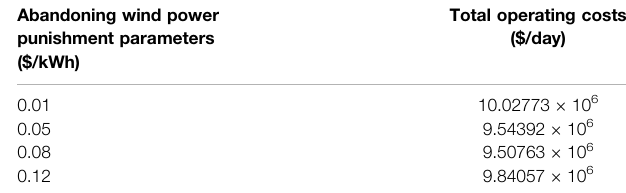
TABLE 5 | Comparison of total operating costs with different abandoning wind power punishment